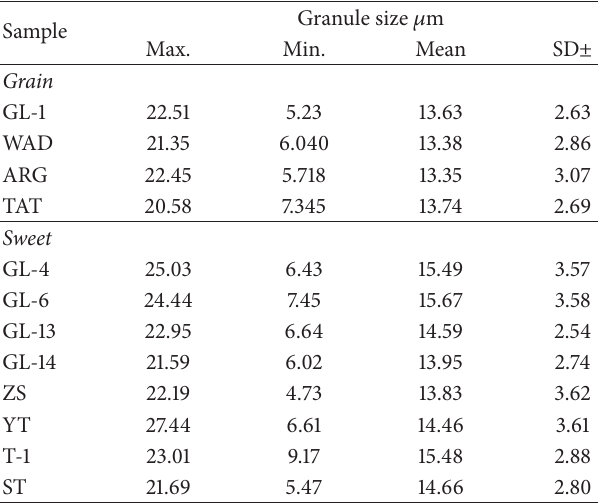
Table 5: The starch granules size for different sweet and grain sorghum